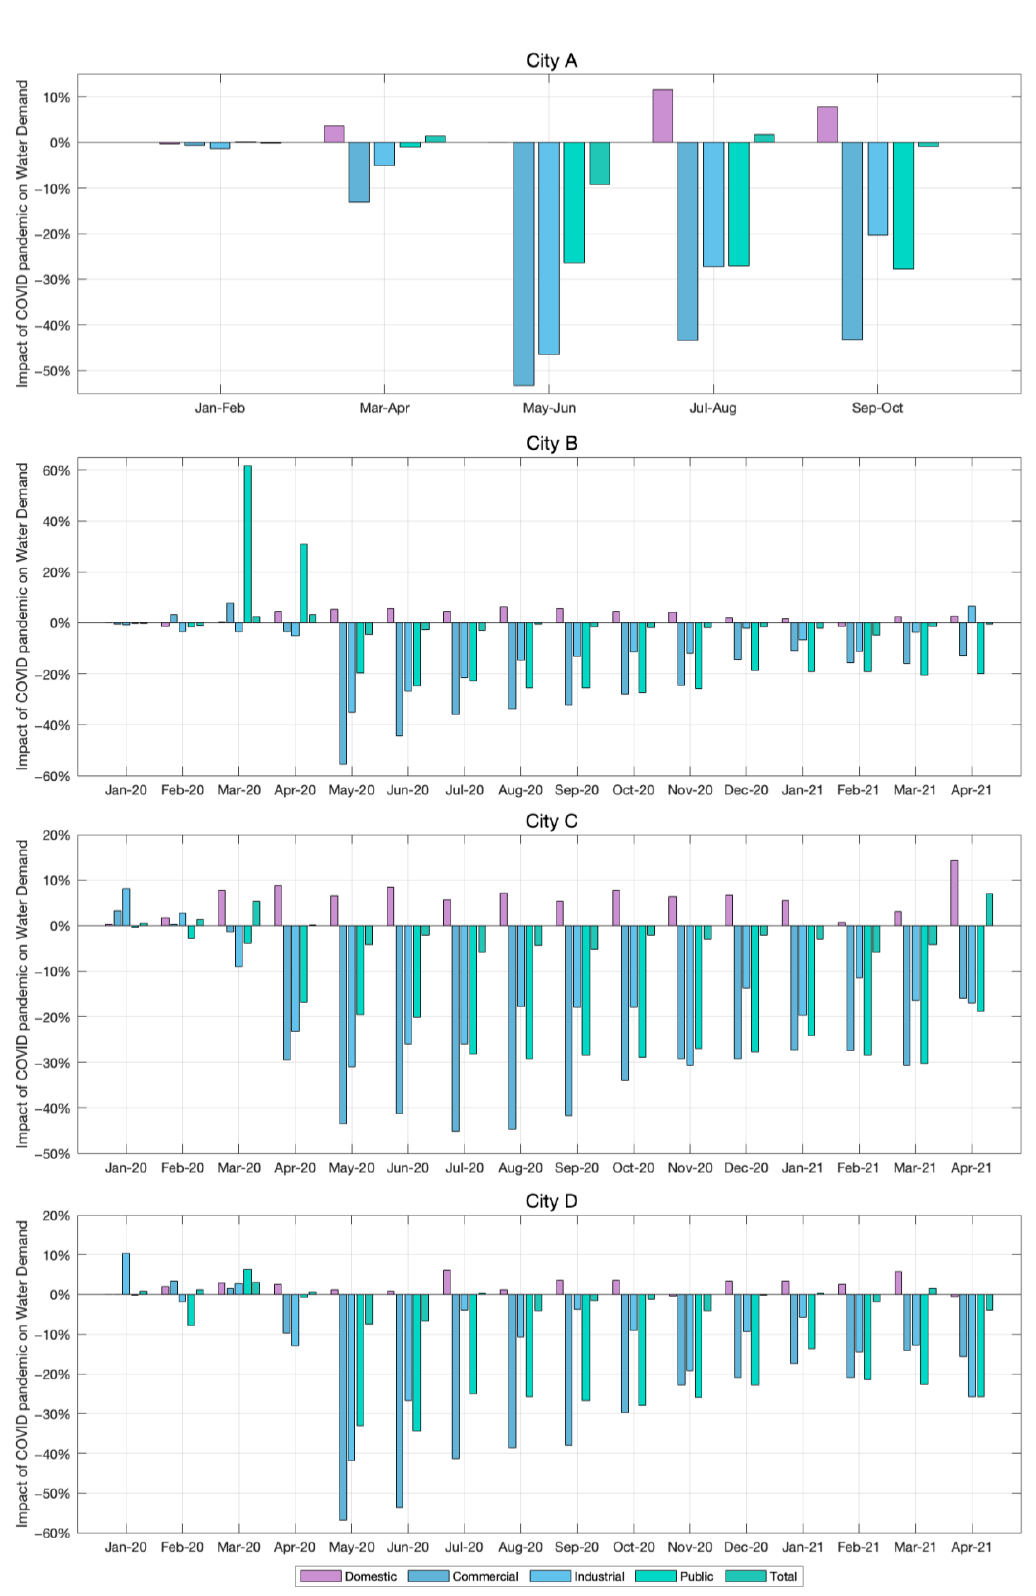
Figure 5. Difference between normal and estimated COVID-19 pandemic water consumption for domestic, commercial, industrial, public, and total categories.